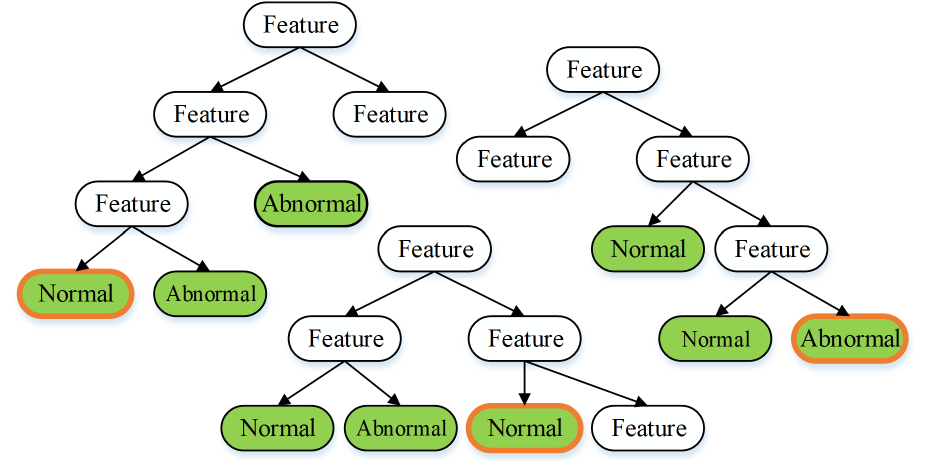
Figure 14. Illustration of random forest method.